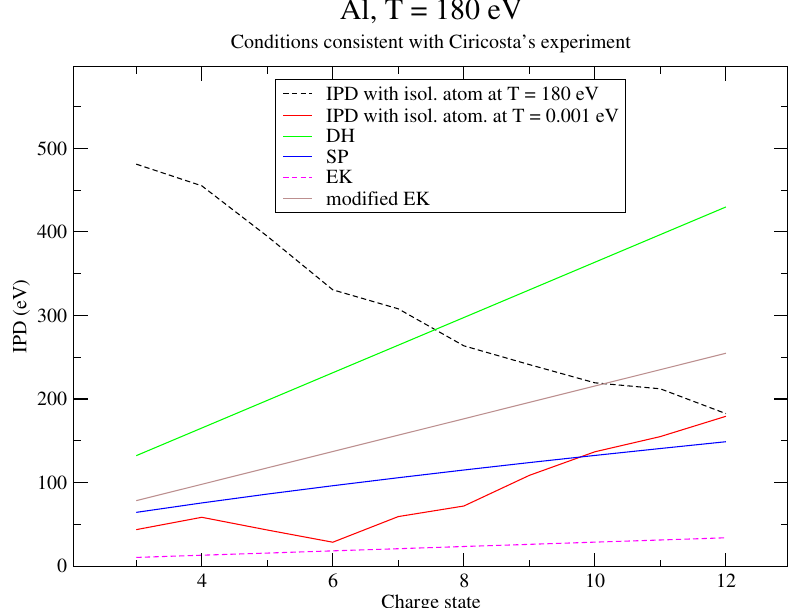
Figure 5. Same as Figure 1 but with a plasma temperature of T = 180 eV.